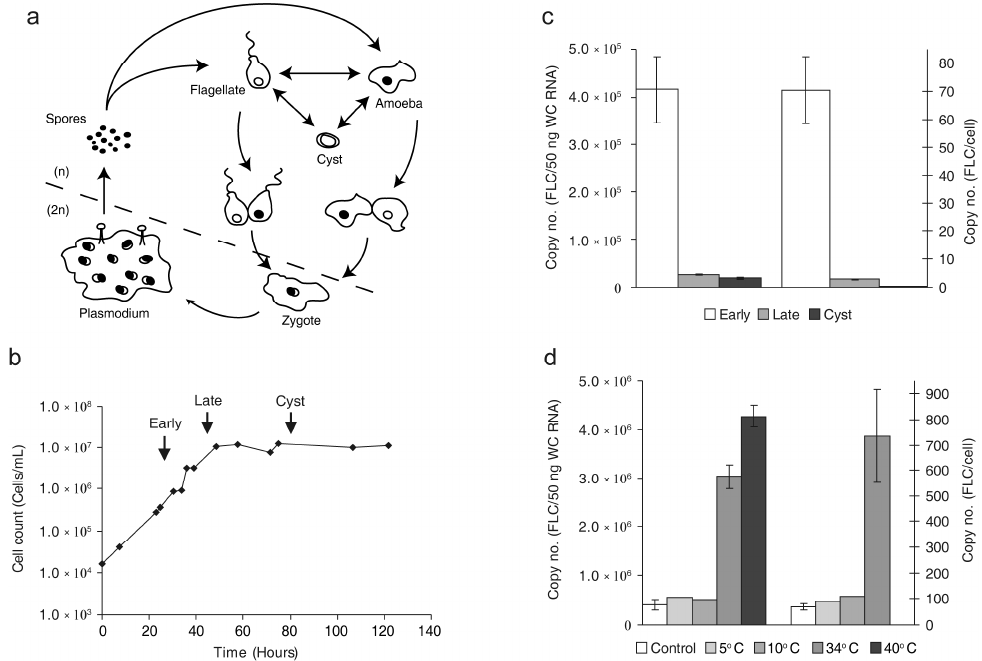
Figure 2. ( a ) The Didymium iridis life cycle is divided into microscopic haploid stages (n) and a macroscopic diploid stage (2n). The haploid cell can reversibly transform between amoeba, flagellated cell and cyst depending on environmental factors. Two compatible flagellates or amoeba fusing to form a diploid zygote initiates sexual reproduction. The zygote grows into a multinucleate plasmodium from which fruiting bodies and spores develop. Spores germinate to form amoebae or flagellates thereby completing the cycle; ( b ) Growth course of Didymium iridis . The initial growth after parallel inoculation of D. iridis and the Escherichia coli food source is exponential. Growing in parallel the Didymium cells will gradually clear the suspension of E. coli and transform from amoebae to flagellates. Then, the growth rate rapidly decreases and the cells transform into dormant and resistant cysts. The cells can be induced to excyst by addition of a bacterial food source. RNA was harvested at the indicated time points: Early (amoeboid cells), Late (flagellated cells) and Cyst; ( c ) Copy number of FLC per 50 ng whole cell (WC) RNA (left y -axis) and per cell (right y -axis) in RNA isolated from the three time points; ( d ) Copy number of FLC per 50 ng WC RNA (left y -axis) and per cell (right y -axis) in exponentially growing cells submitted to cold-shock at 5 °C or 10 °C or heat-shock at 34 °C or 40 °C, respectively. FLC per cell for heat-shock at 40 °C cells was omitted due to impaired cell count. Values in C and D are given as mean ± standard error of the mean.